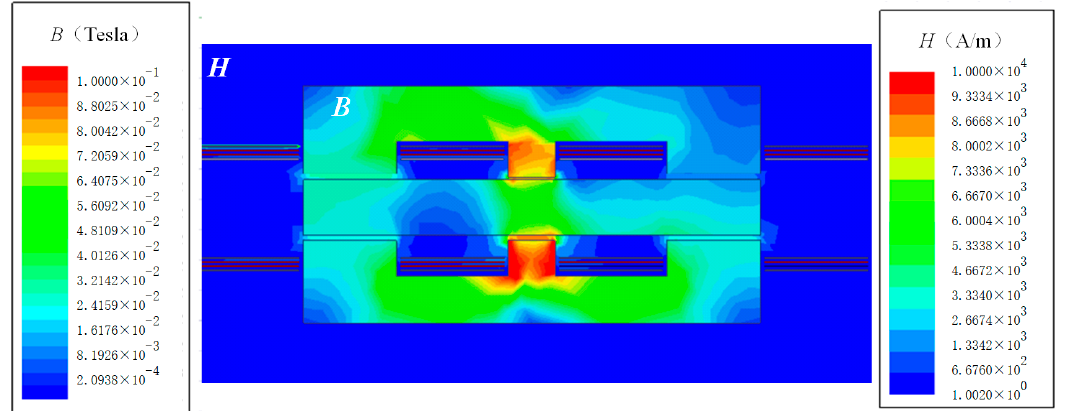
Figure 12. Flux distribution of the improved EIE (E-type and I-type and E-type) core structure.